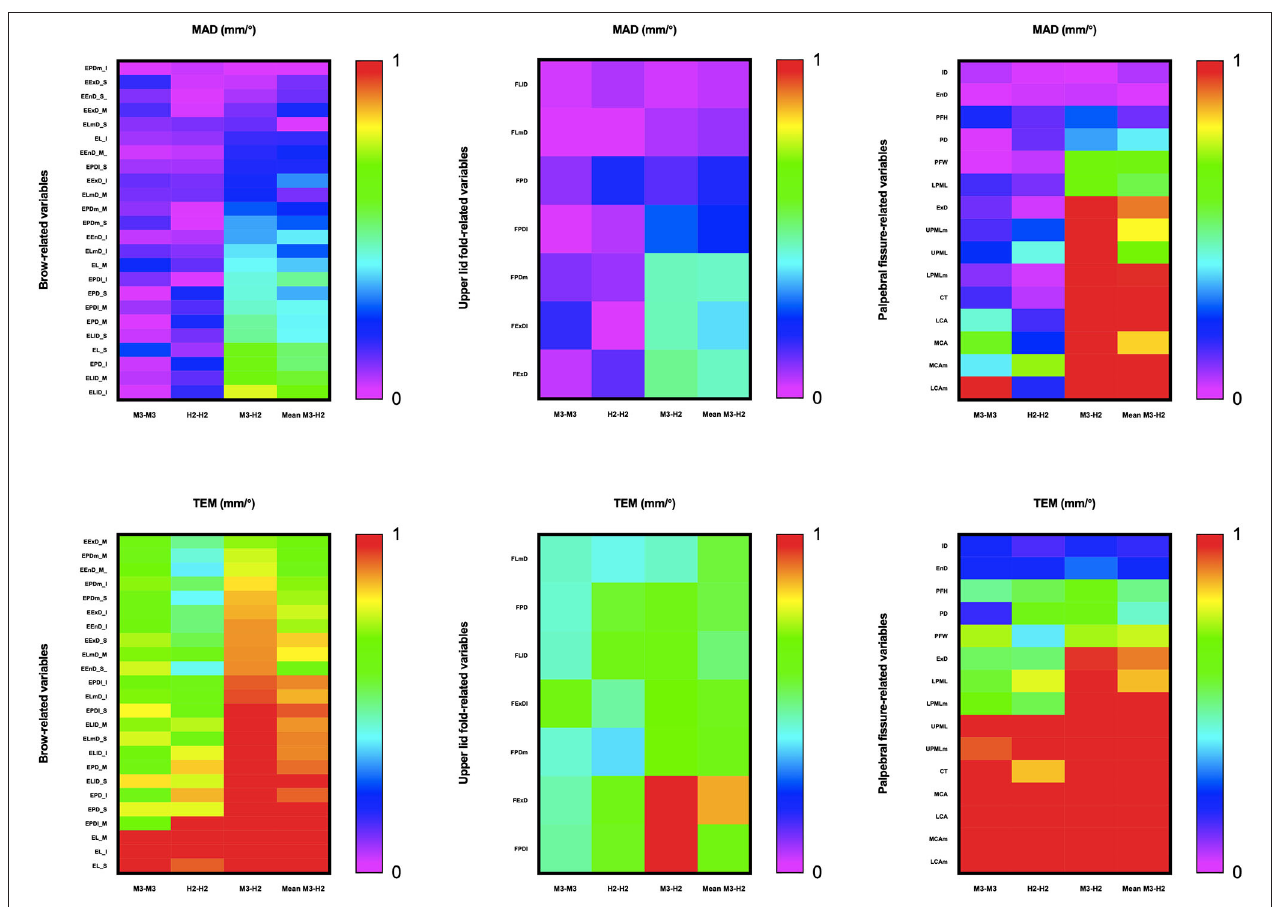
FIGURE 4 | Intra- and inter-device mean absolute difference (MAD) and technical error of measurement (TEM) for periocular measurements on all 3D images. The acceptable error threshold is set to 1 unit.